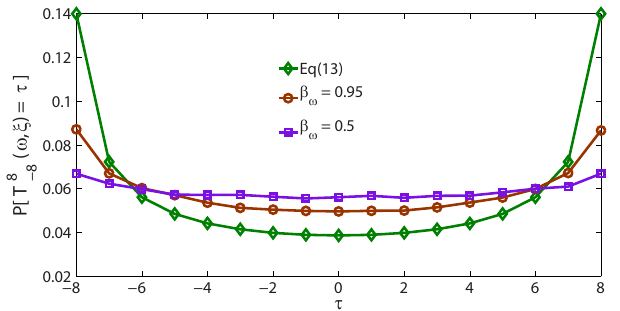
Figure 7. Here we show how Eq. (13) is approached for increasing β ω . The mapping becomes exact in the limit β ω → 1, where ω(t) is a constant-valued series. Fixed parameters are: (cid:127) = 32, with N = 2 18 realizations.